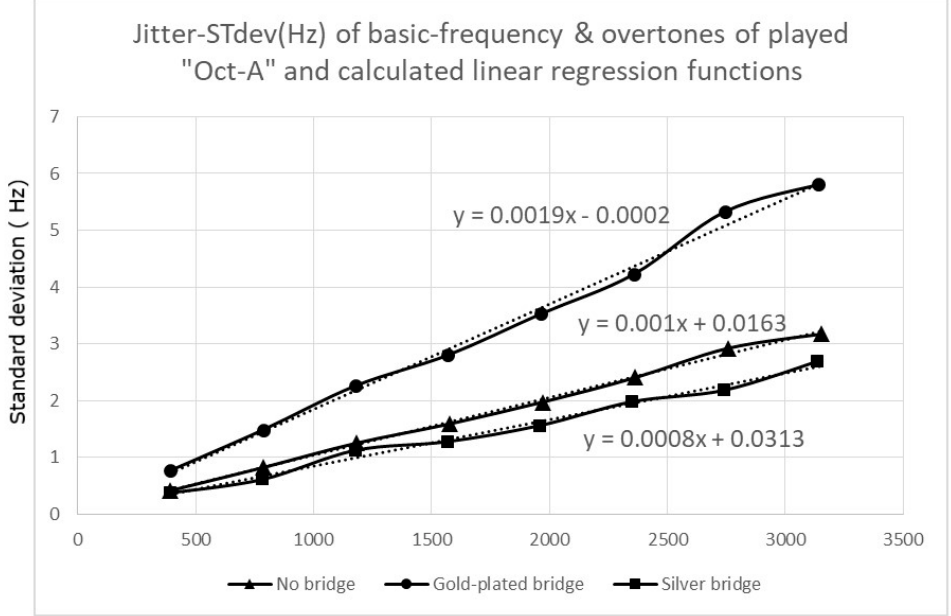
Figure 6. Standard deviation of the frequency jitter of the basic frequency and the related overtones (harmonics) of a played tone-Oct-A (392 Hz) on the saxophone with and without metal bridges mounted. The dashed lines represent the linear regression of the displayed data, with their respective linear function (see Material and Methods). The upper displayed function represents the linear regression of the data for the gold-plated bridge, while the lowest function represents the regression of data for the silver bridge.